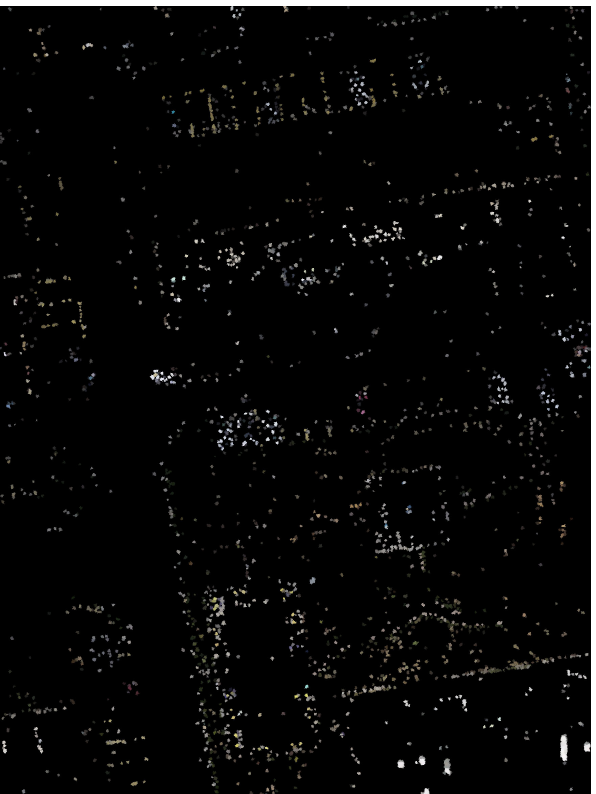
Figure 2. A top view of sparse 3D points generated by the SfM algorithm in a raster with a designed spatial